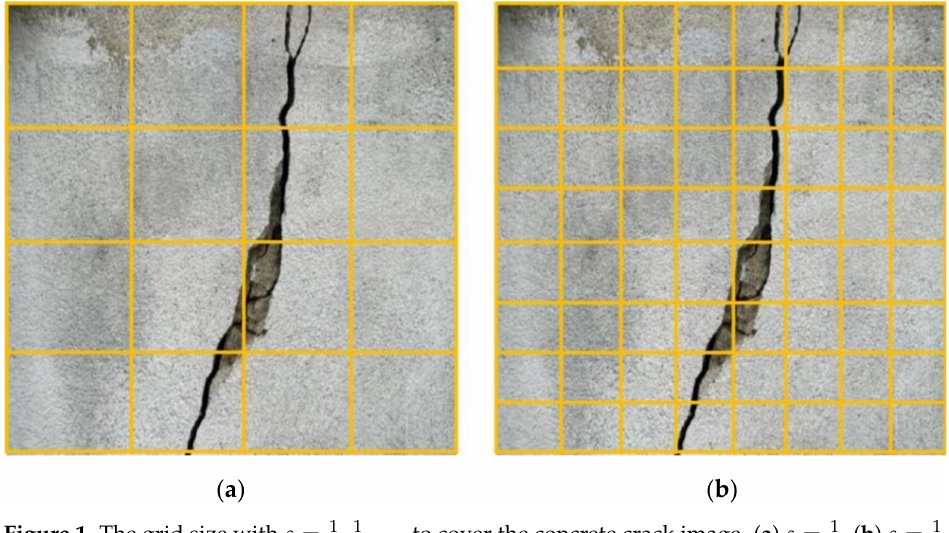
, 1 , · · · to cover the concrete crack image. ( a ) ε = 1 8 4